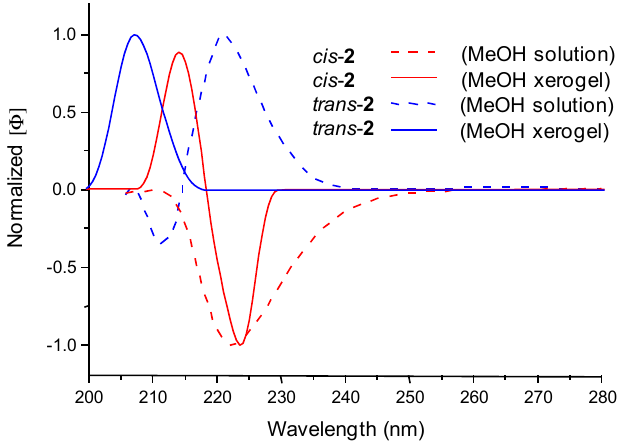
Figure 6. Normalized CD spectra of cis -and trans - 2 , respectively, in methanol solution (2.4 mM for cis - 2 and 2.7 mM for trans - 2 ) and xerogel at the mgc in methanol in KBr (20 mM) at 25 °C.